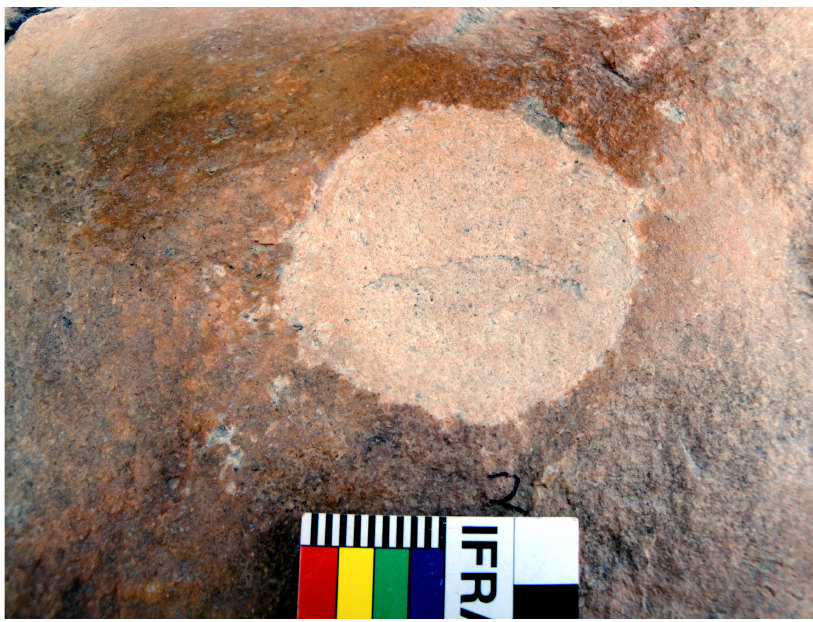
Figure 11. Replicated saucer shaped cupule, RC-2.